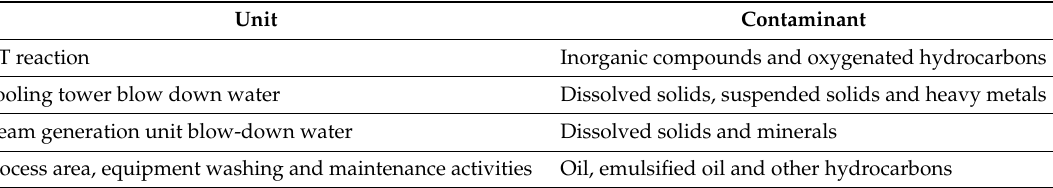
Table 1. Main sources of GTL